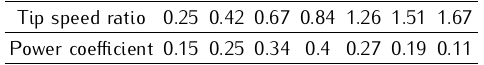
Table 2. Extracted power coefficient variation with tip speed ratio at inlet flow of 2.5 m/s.